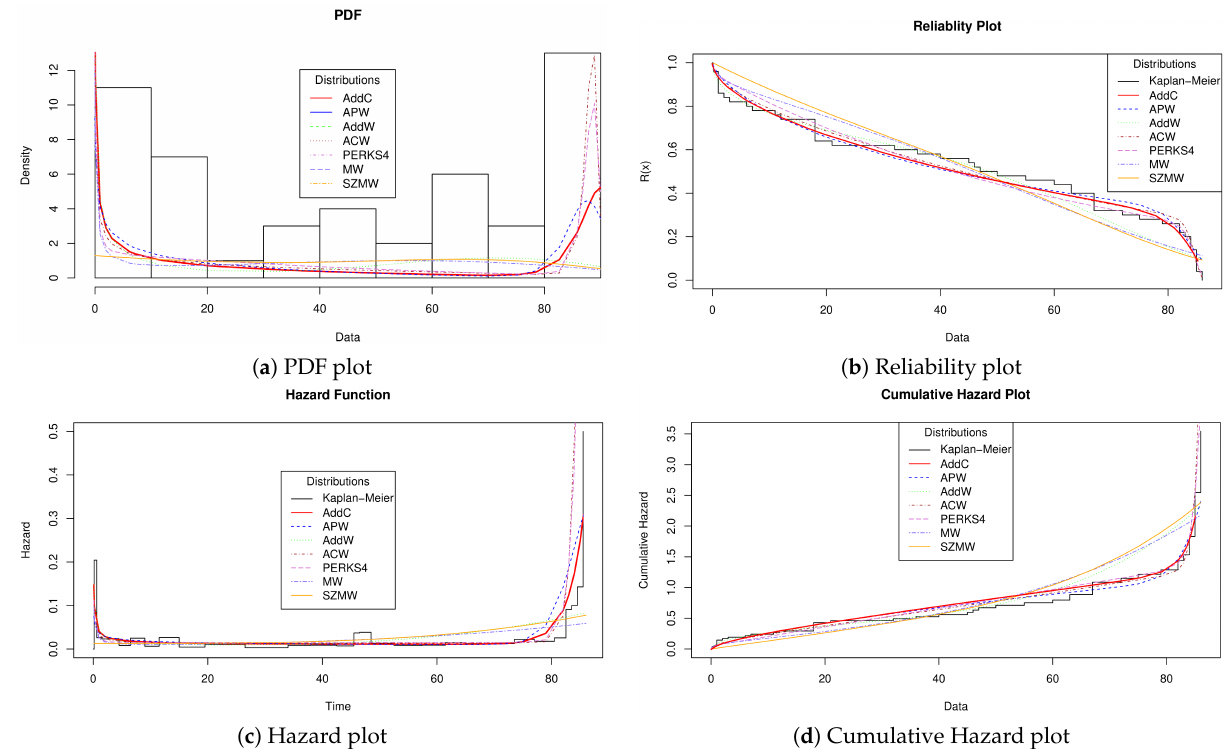
Figure 4. Reliability Plots for Lifetime data presented in Table